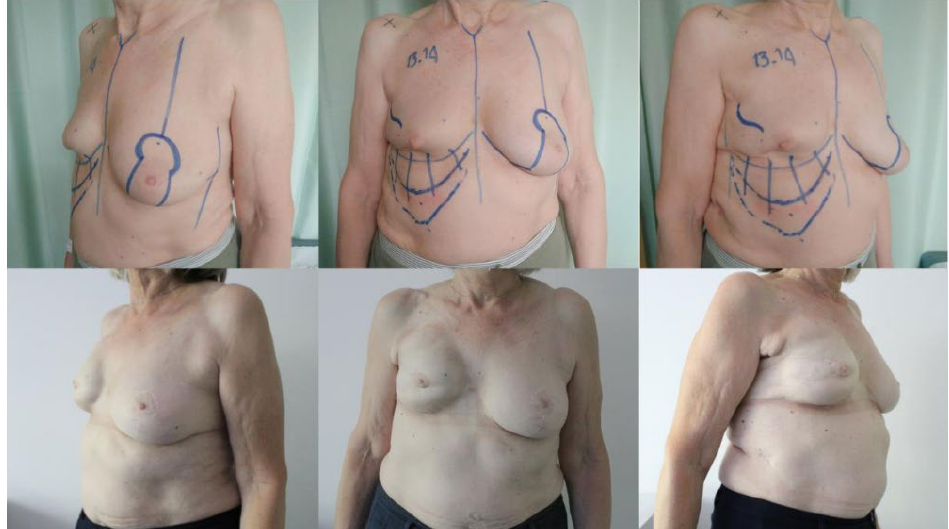
Figure 1. Pre-operative and post-operative pictures of a 67-year-old patient. Breast reconstruction was performed using a 335 cc anatomical implant combined with an abdominal advancement flap. The patient was satisfied with her final result, giving 8 points out of 10 according to the VAS score. Despite the occurrence of a capsular contracture, grade 2 according to Baker, the patient refused additional surgery.